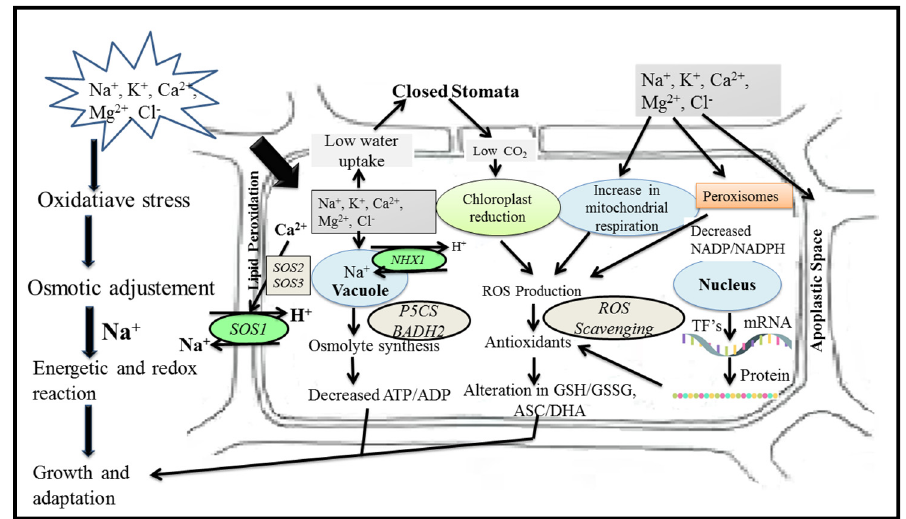
Figure 5. Salt stress tolerance mechanisms of halophytes in a saline environment.